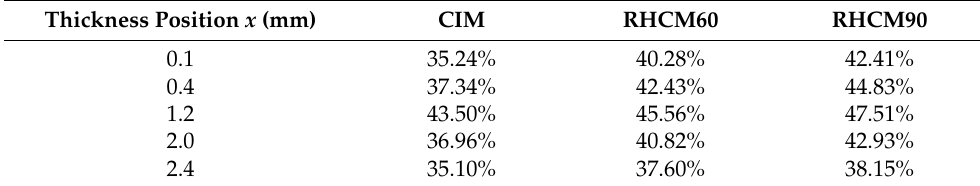
Figure 6. Crystallinity diffraction pattern of parts with different molding conditions by WAXD: ( a ) CIM, ( b ) RHCM60, ( c ) RHCM90. Table 2. Crystallinity of each layer under different